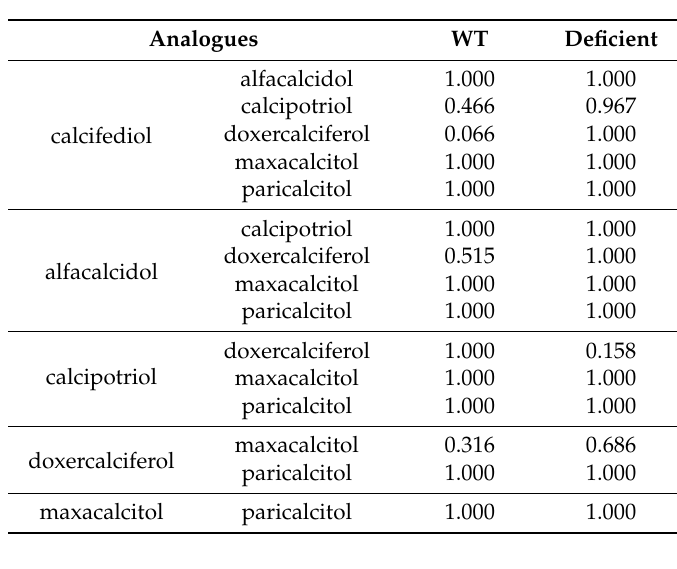
Table 2. Comparison of the effects of calcifediol and its analogues on β -secretase activity in either WT or vitamin D deficient mouse brains. No significant differences between calcifediol and the analogues tested with Post Hoc